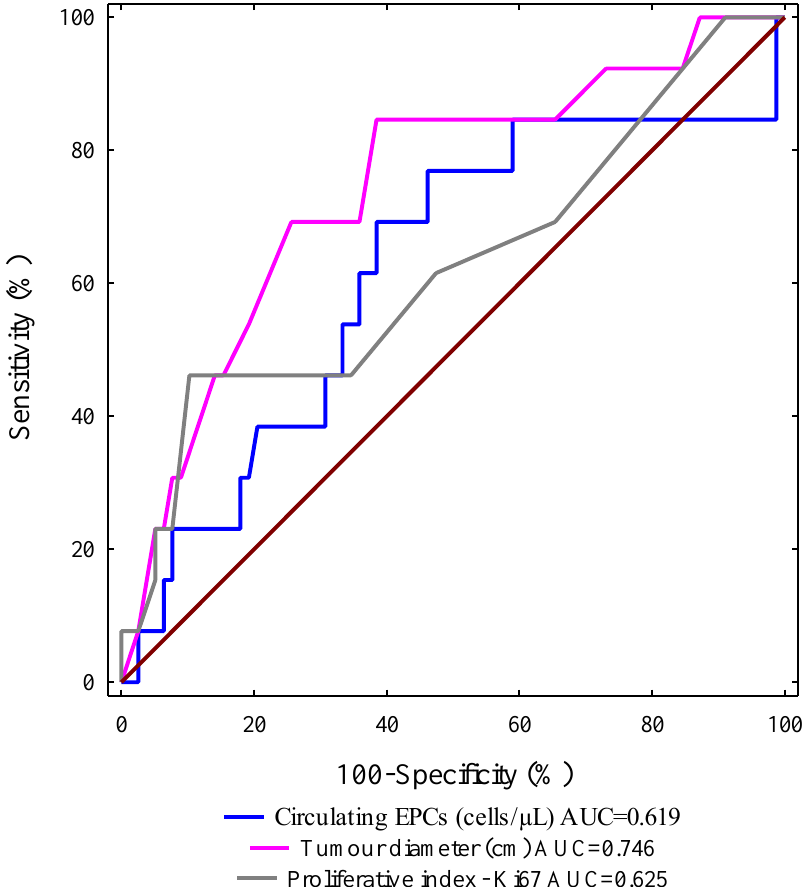
Figure 5. A graph showing three ROC curves for the number of circulating endothelial progenitor cells (EPCs), tumour diameter, and Ki67 expression with different values of area under the curve. The most accurate indicator for disease recurrence presents an area of 0.746 under the curve, which was reached for tumour diameter ( p = 0.0001).